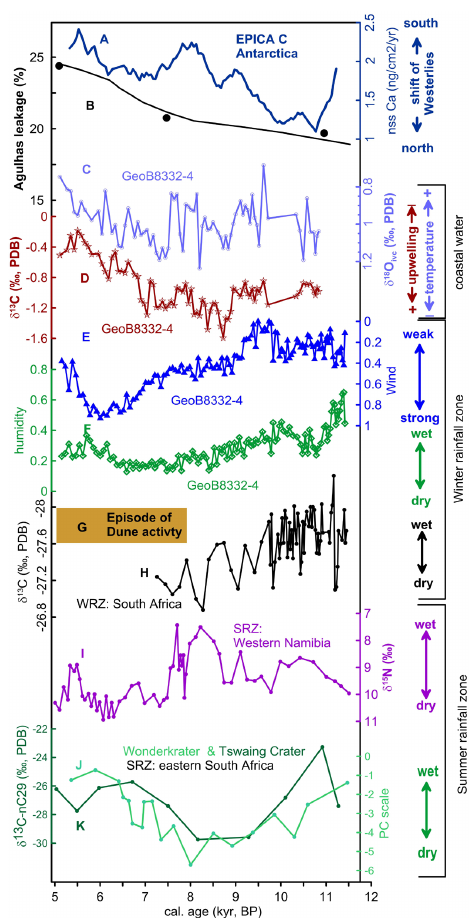
Fig. 6. Early and middle Holocene paleo-environmental proxies reconstructed from climate archives in southwestern Africa, east- ern South Africa, and Antarctica. (A) 7-point running average of nss Ca 2 + analyzed in EPICA Dome C ice core indicating vari- ation of dust incursion over Antarctica in response to latitudi- nal shifts in the austral westerlies (Roethlisberger et al., 2002). (B) Estimate of Agulhas leakage into the South Atlantic (Peeters et al., 2004). (C) Ice-volume-corrected δ 18 O ( δ 18 O ivc ) and (D) δ 13 C analyzed in N. pachyderma (sinistral) in core GeoB8332- 4. (E) Wind strength ([EM1/EM1 + EM2]) and (F) humidity ([EM3/EM1 + EM2 + EM3]) indices inferred from grain size anal- ysis and end-member modeling from the lithogenic fraction in GeoB8332-4. (G) Orange box indicates time interval (8–4 kyr BP) of enhanced dune activity in the coastal area of southwestern Africa (Chase and Thomas, 2006). (H) δ 13 C and (I) δ 15 N analyzed in hyrax dung from the WRZ in South Africa (Chase et al., 2011) and the SRZ in western Namibia (Chase et al., 2009), respectively. (J) Relative moisture estimates based on principal component (PC) analysis of pollen time series from Wonderkrater (Scott el al., 2012). (K) δ 13 C signature of an n-alkane (nC29: n-alkane with 29 C